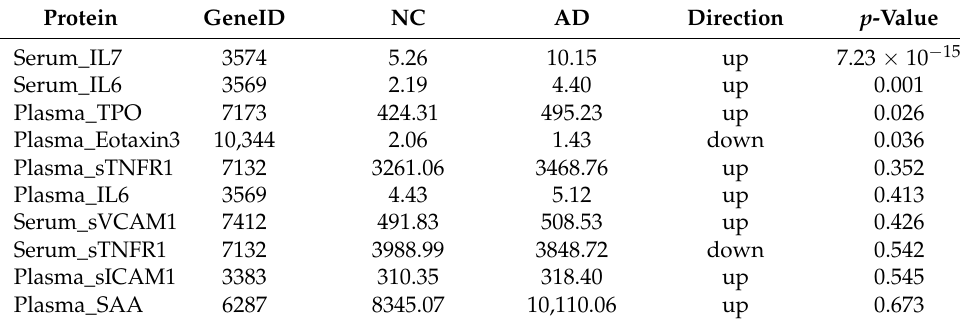
Table 2. Protein changes in the selected serum and plasma biomarker